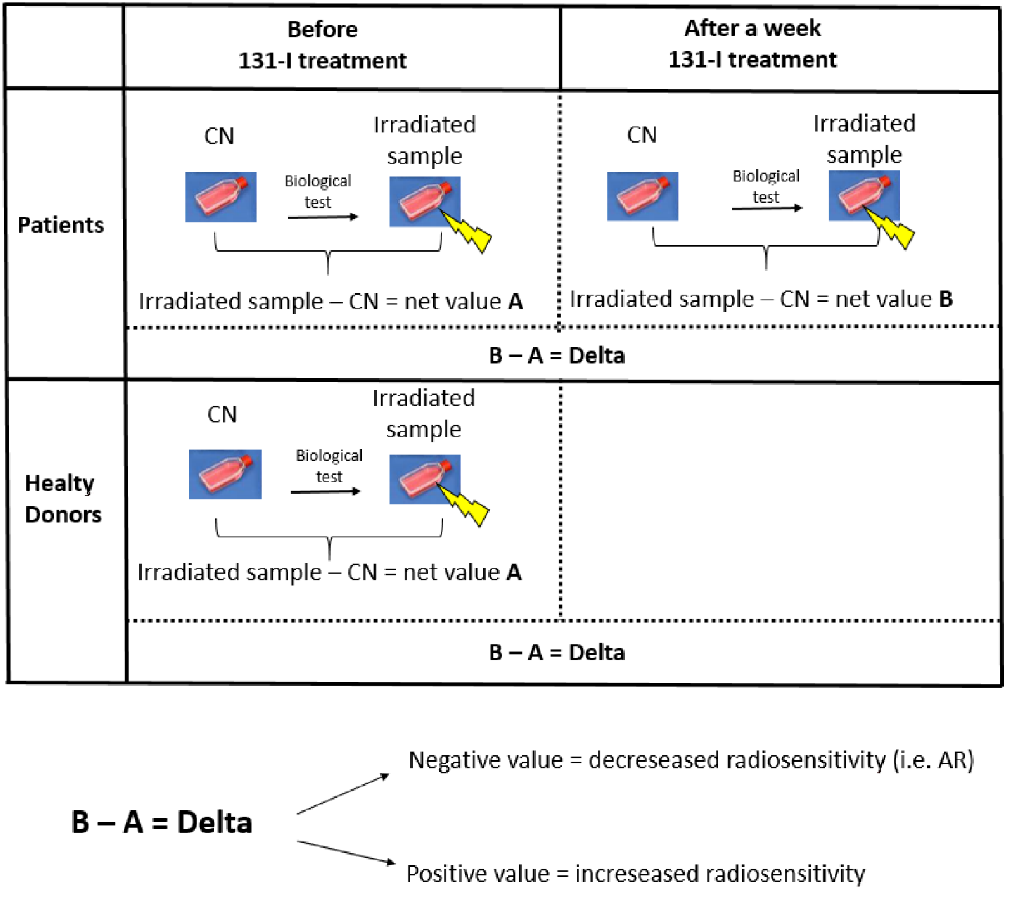
Figure 8. Radiosensitivity’s modulation. The experimental design behind the study and explanation of the delta parameter considered in the results: patients with a negative delta (−) or positive delta (+) show a decreased or increased radio-sensitivity, respectively.